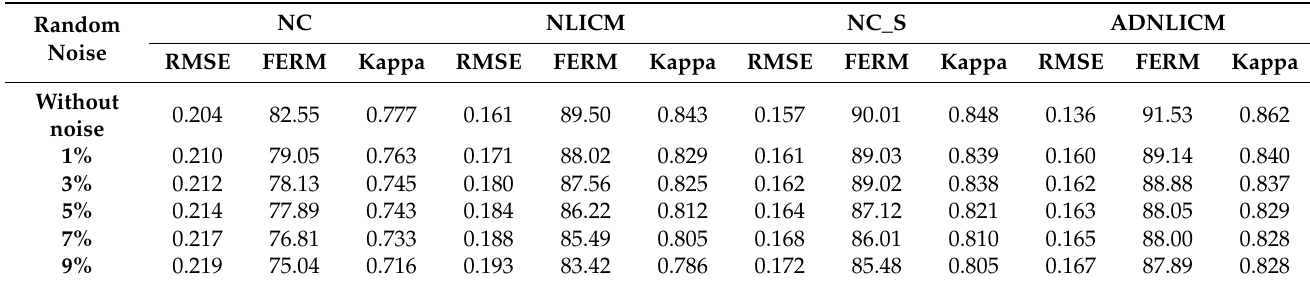
Table 8. RMSE, FERM, and Kappa of the algorithms concerning different random noise (pepper and salt-and-pepper noise) for site 1 (Haridwar).